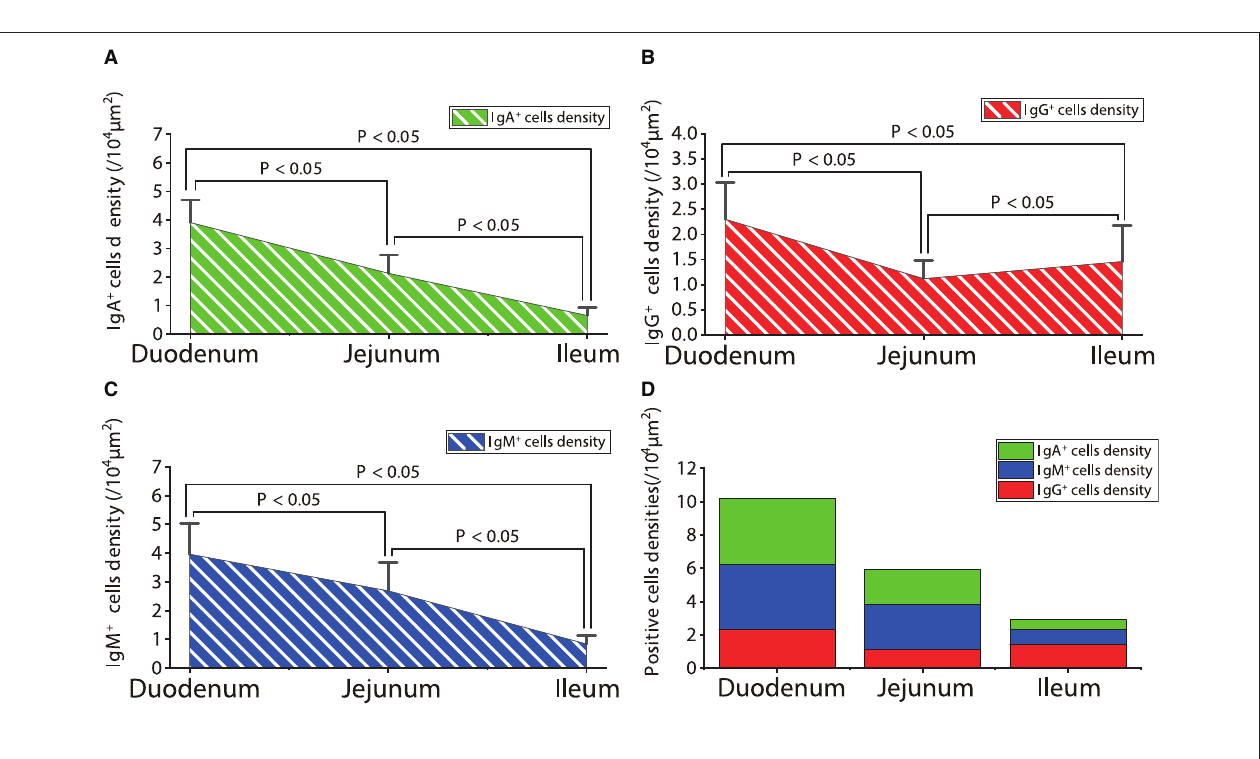
FIGURE 11 | Density of IgA + , IgG + and IgM + cells in the small intestine of healthy sheep. (A) The distribution density of IgA + cells; (B) The distribution density of IgG + cells; (C) The distribution density of IgM + cells; (D) The total densities of IgA + cells, IgG + cells, and IgM + cells. P < 0.05 means significant difference, P > 0.05 means not significant difference.